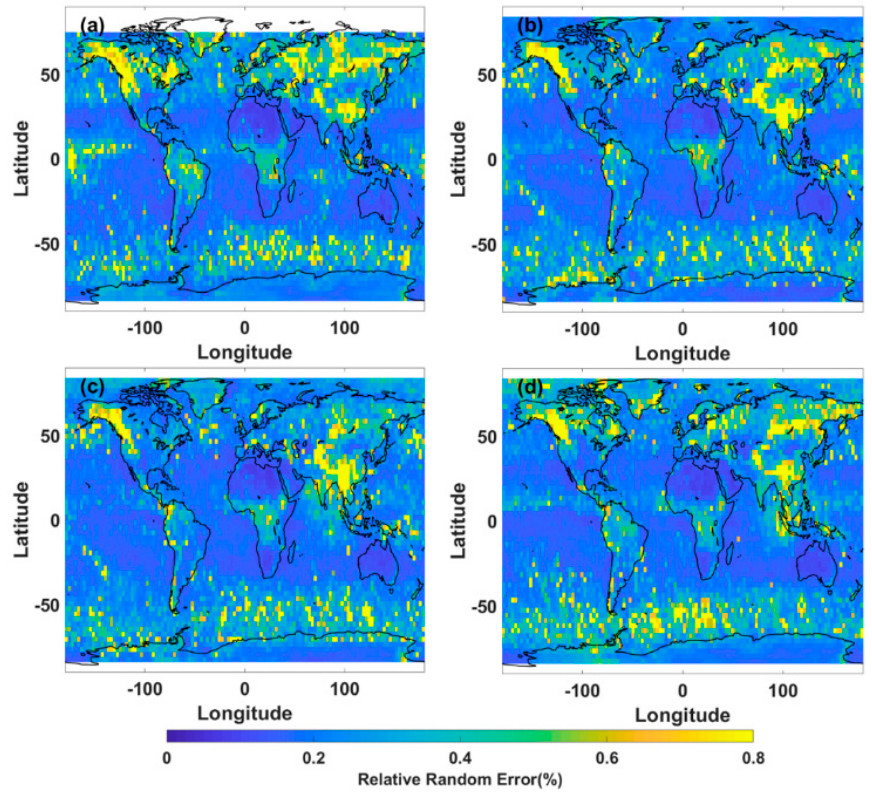
Figure 6. RREs results of AC-IPDA lidar from December 2015 to November 2016. ( a ) winter; ( b ) spring; ( c ) summer; and ( d ) fall.